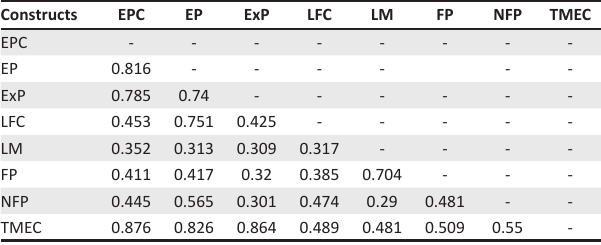
Performance; TMEC, Top Management’s Characters & Ethical Commitment.